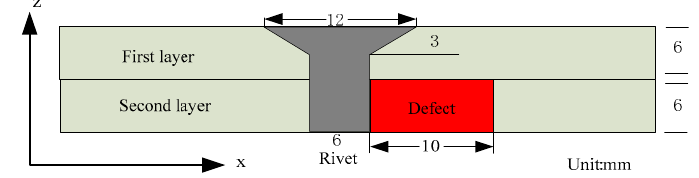
Figure 9. Geometry of the test sample used in the finite element model (FEM) model.